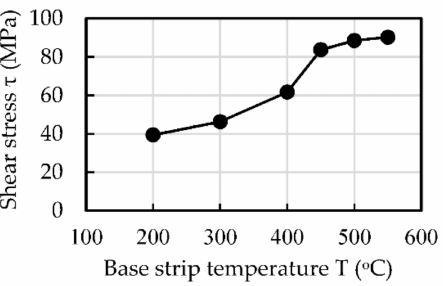
Figure 4. Effect of base strip temperature on bonding force at the interface between the base and overlay